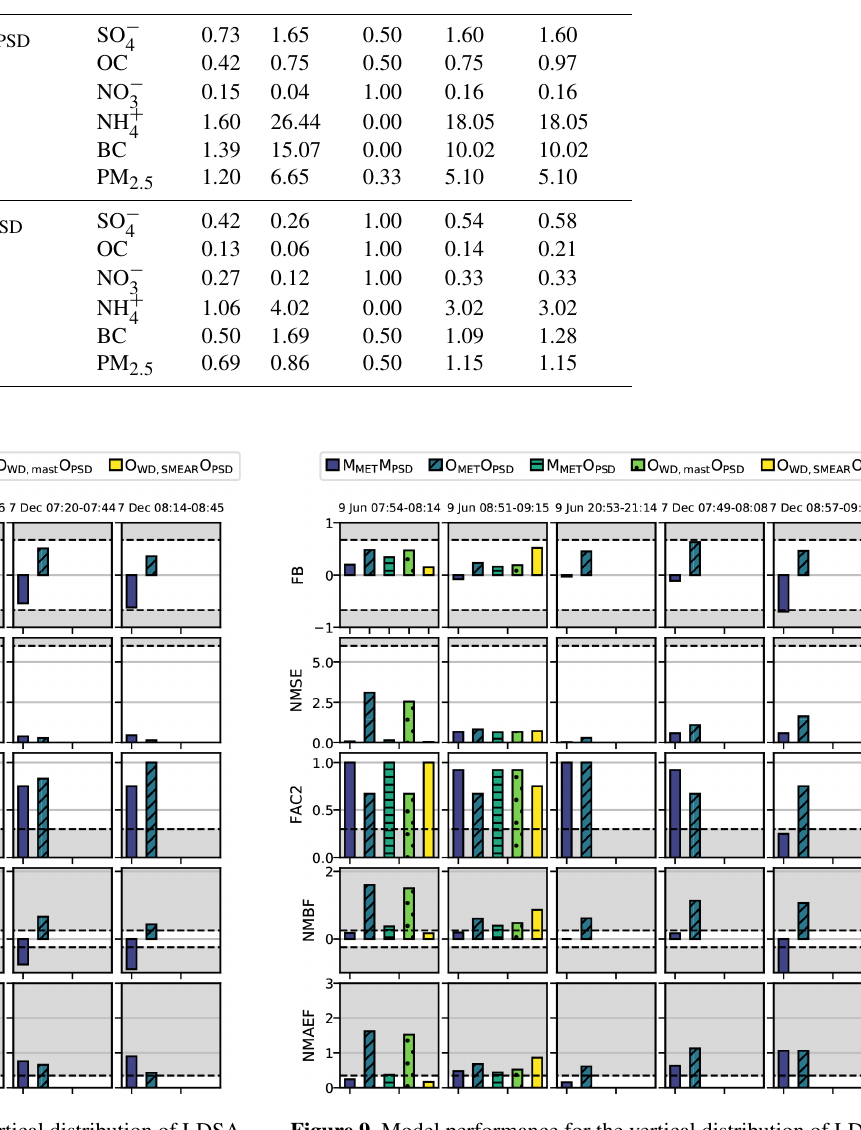
Figure 9. Model performance for the vertical distribution of LDSA opposite the supersite. The grey area indicates that the value exceeds the acceptance criteria given in Table 5. See Fig. 4 for